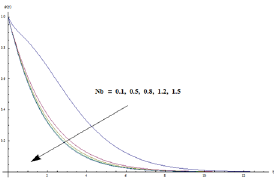
for different values of Nt when l 1 ~ 0 : 3, b ~ 0 : 2, M ~ 0 :